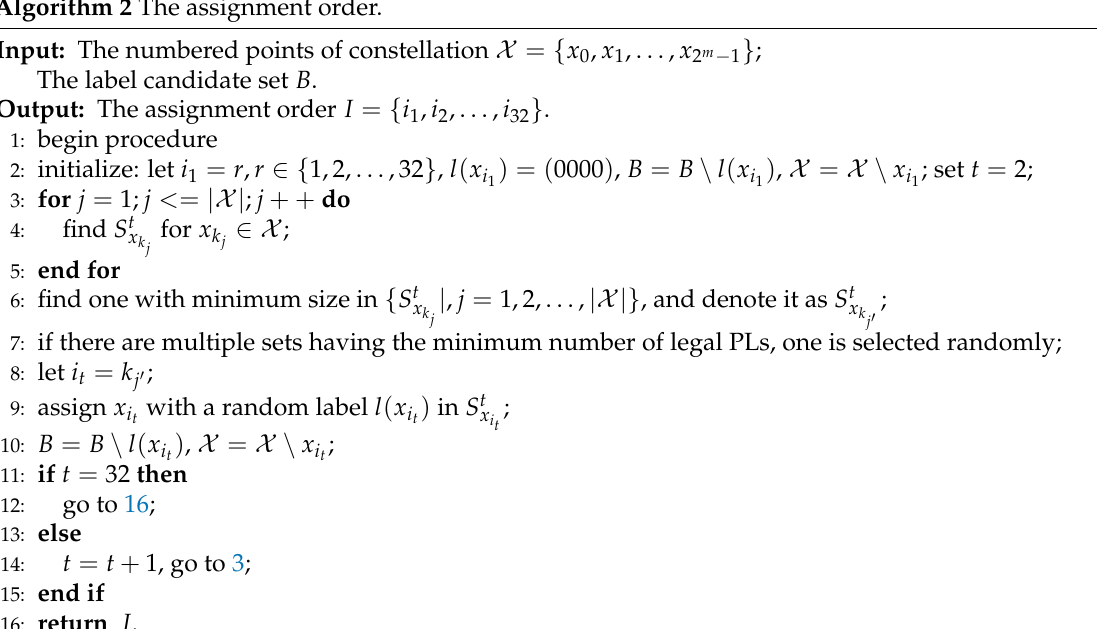
Algorithm 2 The assignment order.